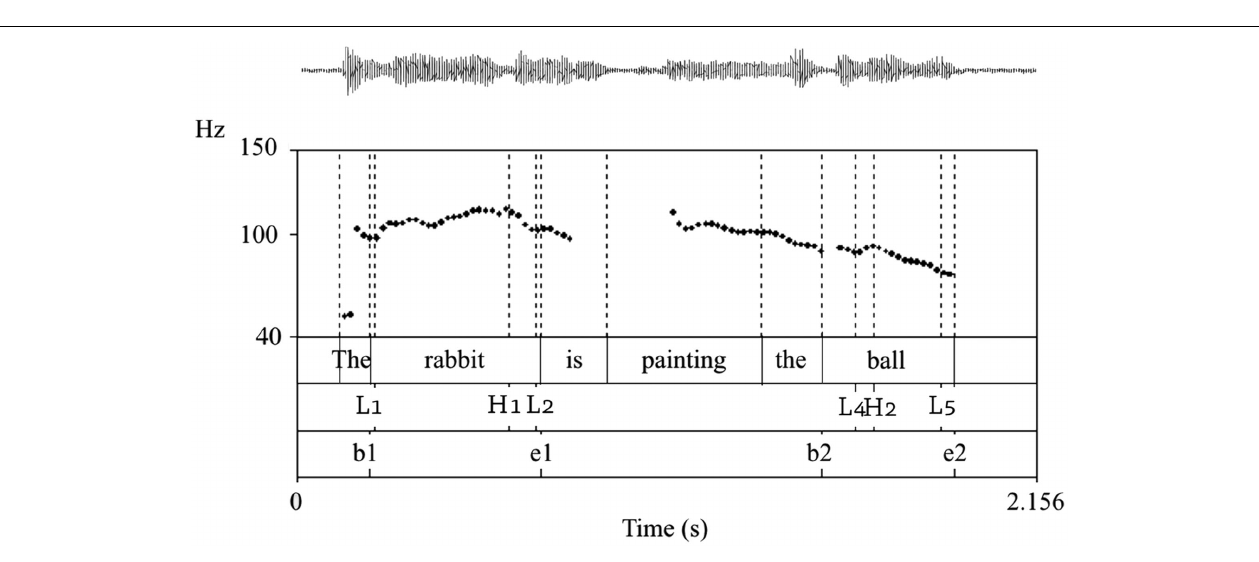
FIGURE 3 |Acoustic analysis. The sentence “The rabbit is painting the ball” was produced as an answer to the question “What is the rabbit painting?” by a speaker with A-highL.The landmarks in the subject noun “rabbit” and the